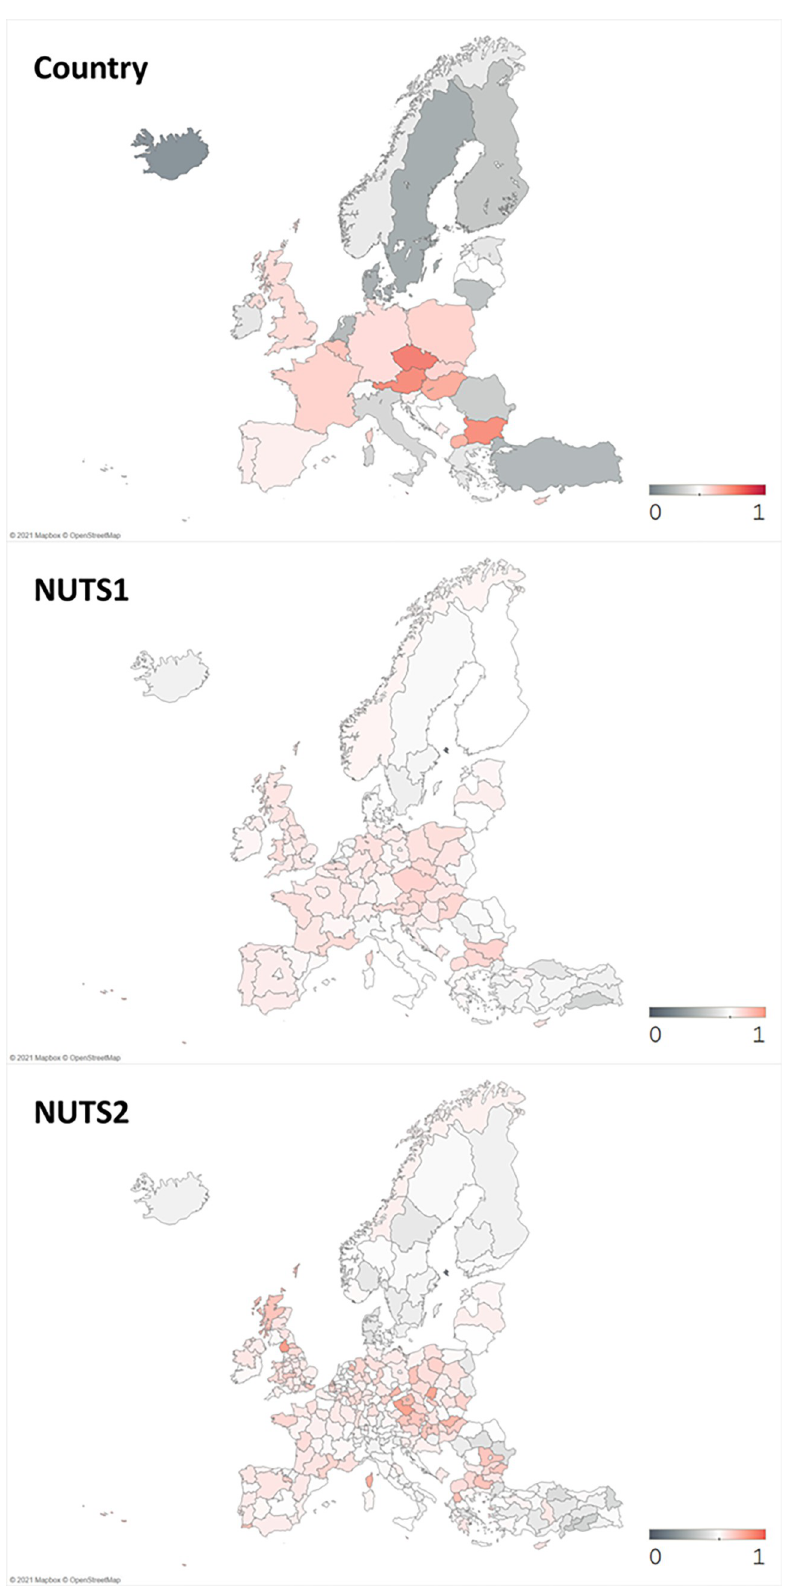
Fig 4. Average novelty of publications (in normalized log scale). Source: Authors’ illustration. https://doi.org/10.1371/journal.pone.0271678.g004 PLOS ONE | https://doi.org/10.1371/journal.pone.0271678 July 25,